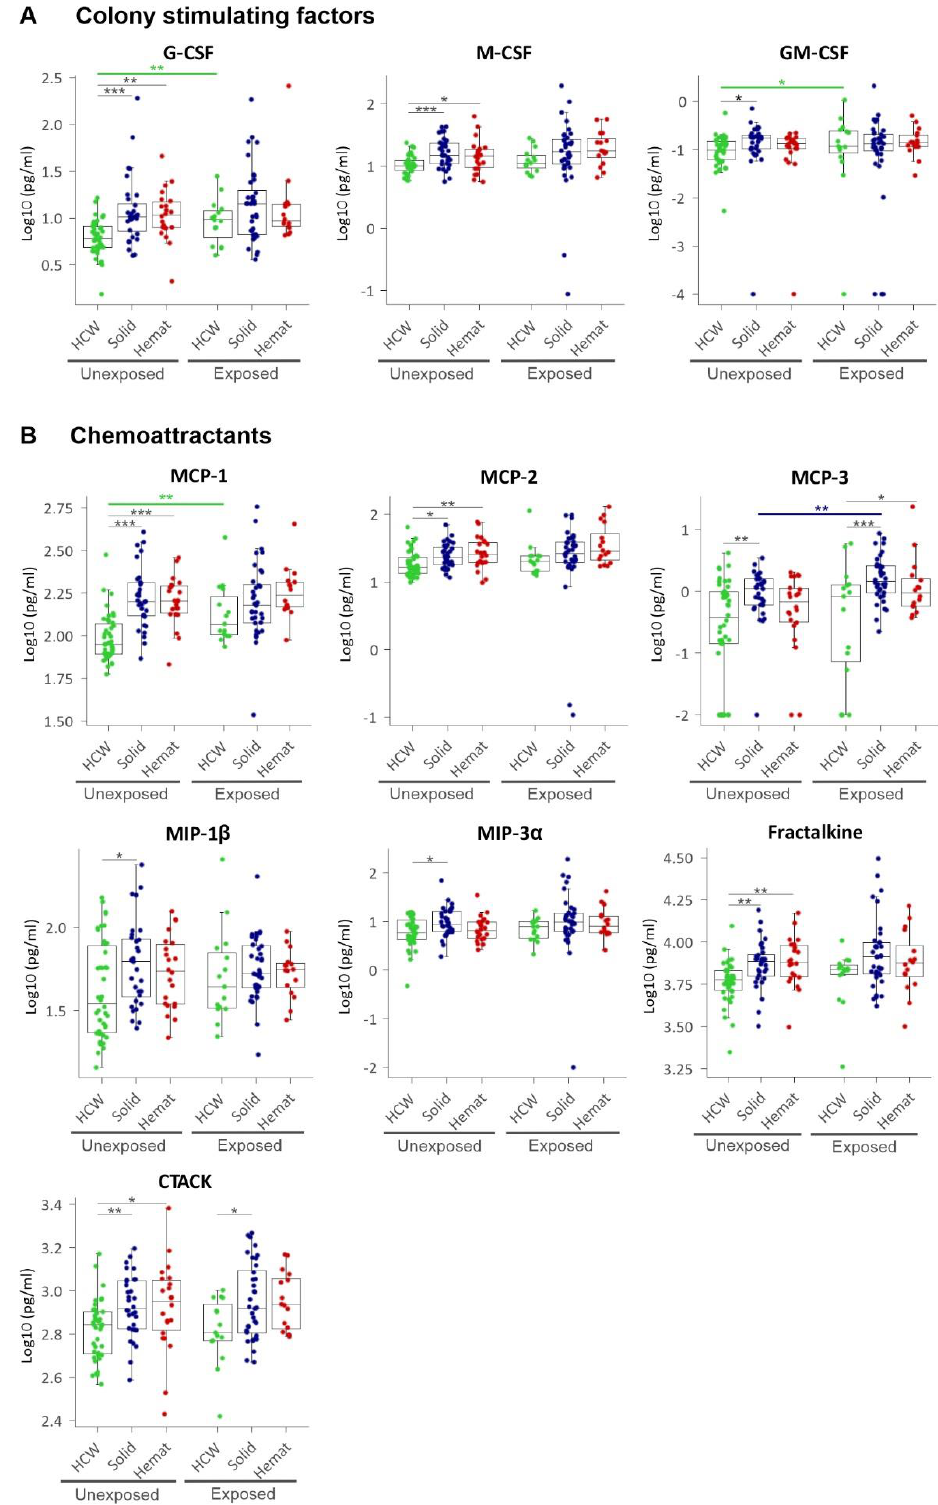
Figure 6. Plasma levels of ( A ) colony stimulating factors (CSFs) and ( B ) monocyte chemoattracting proteins (MCPs), macrophage inflammatory proteins (MIPs) and other chemokines. HCW, health care workers (green); solid, patients with solid tumours (blue); hemat, patients with haematological malignancies (red). Each dot represents the sample closest to exposure in the case of exposed patients and an average of multiple timepoints, when available, for unexposed patients. * p < 0.05, ** p < 0.01, *** p <